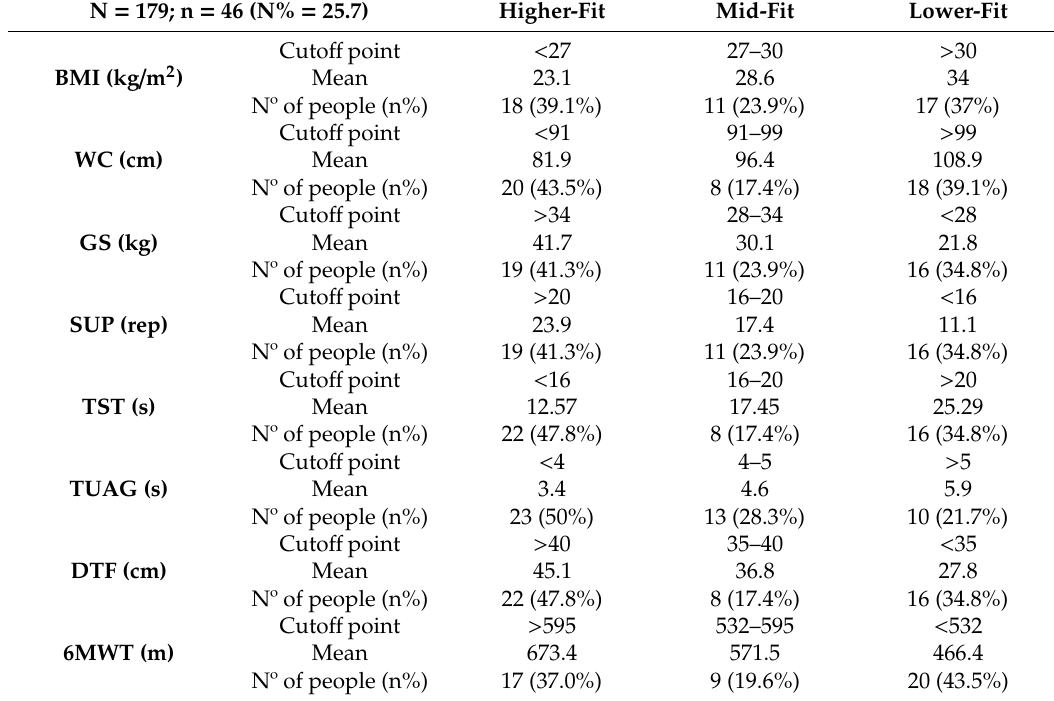
Table 1. Younger men ( < 30 years old) results for each variable categorized in 3 physical fitness levels. N = 179; n = 46 (N% = 25.7)